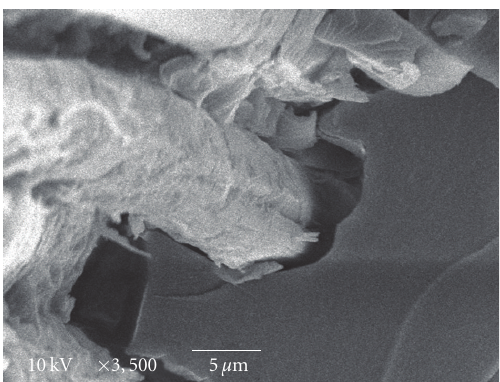
Figure 3: A representative SEM image of a failed composite sample with unretted (0h) fibers.